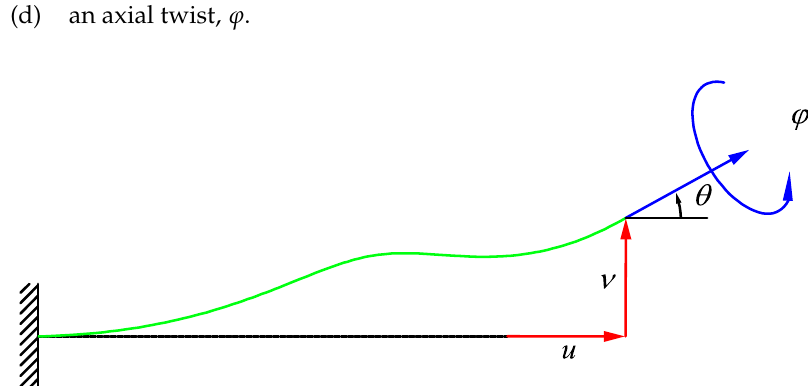
Figure 3. General deformation of a cantilever beam with axial and lateral displacements in addition to flexural and torsional rotations in its free end.